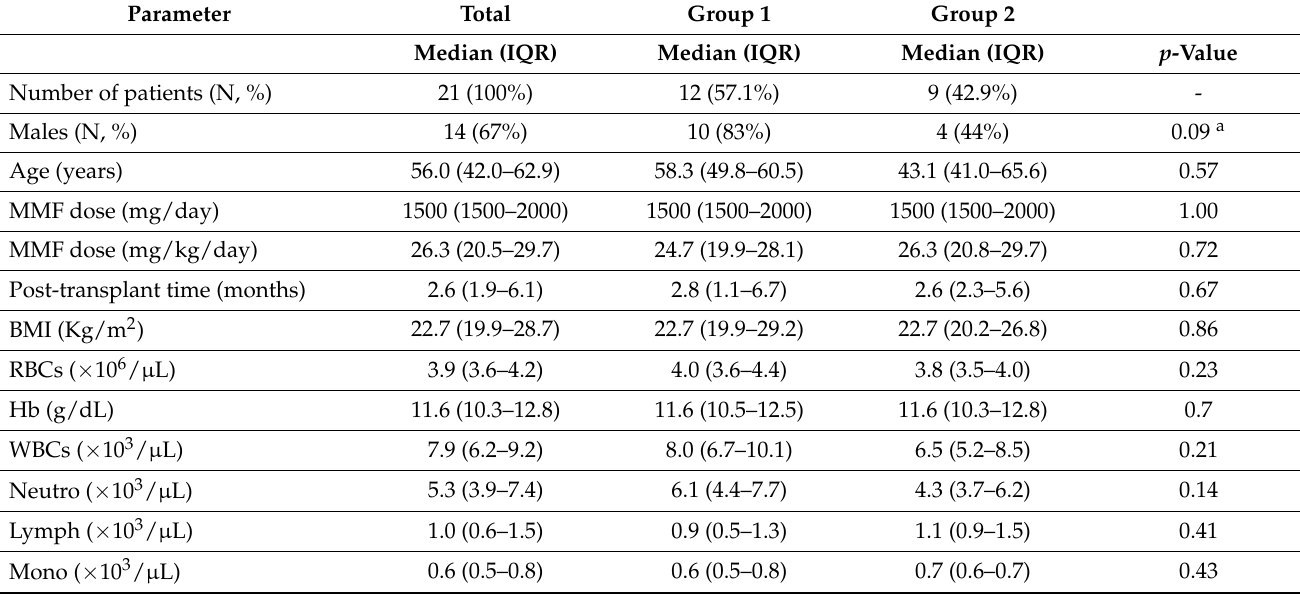
Table 1. Patients’ baseline demographical and clinical data are reported as overall and according to the immunosuppressive